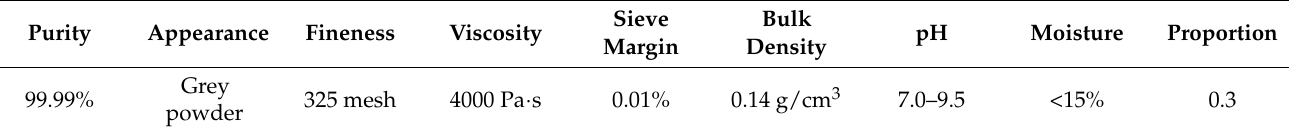
Table 2. Basic performance parameters of palygorskite